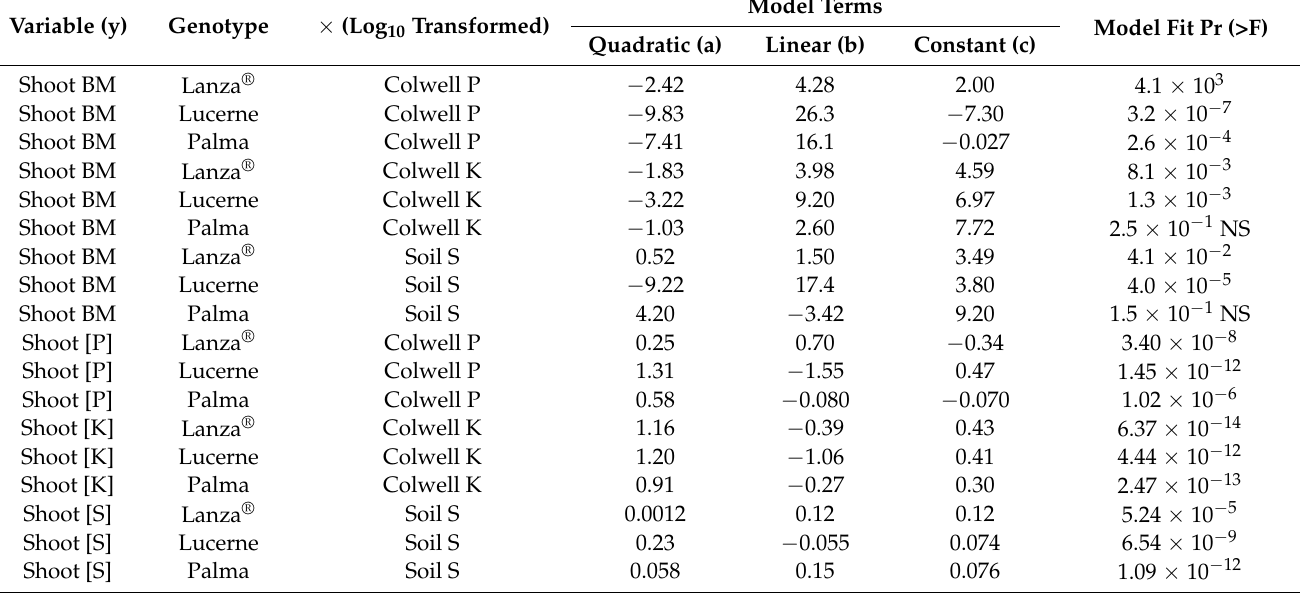
Table 6. Model descriptions for curves fitted to shoot biomass (BM), shoot nutrient concentrations ([K], [P], or [S]) and nodulation score in response to soil test results (Colwell P, Colwell K, Soil S). Model fits were quadratic (y = ax 2 + bx + c); we used a log10 transformation of soil fertility as the × variable, and its significance (Pr (>F)) is presented. In two cases, no significant fit (NS) was available for shoot BM in response to soil nutrient levels, and, in two cases, there was no significant fit for nodulation score.